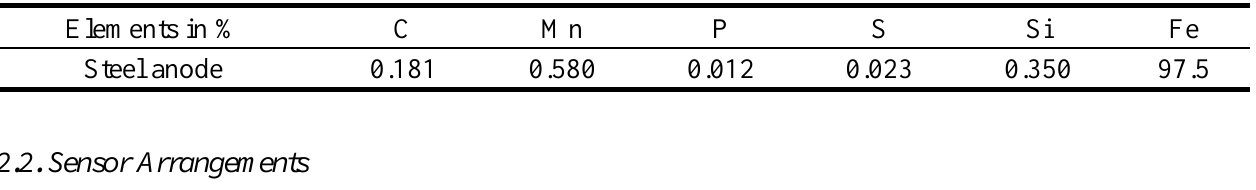
Table 1. Chemical composition of the steel anodes used in this